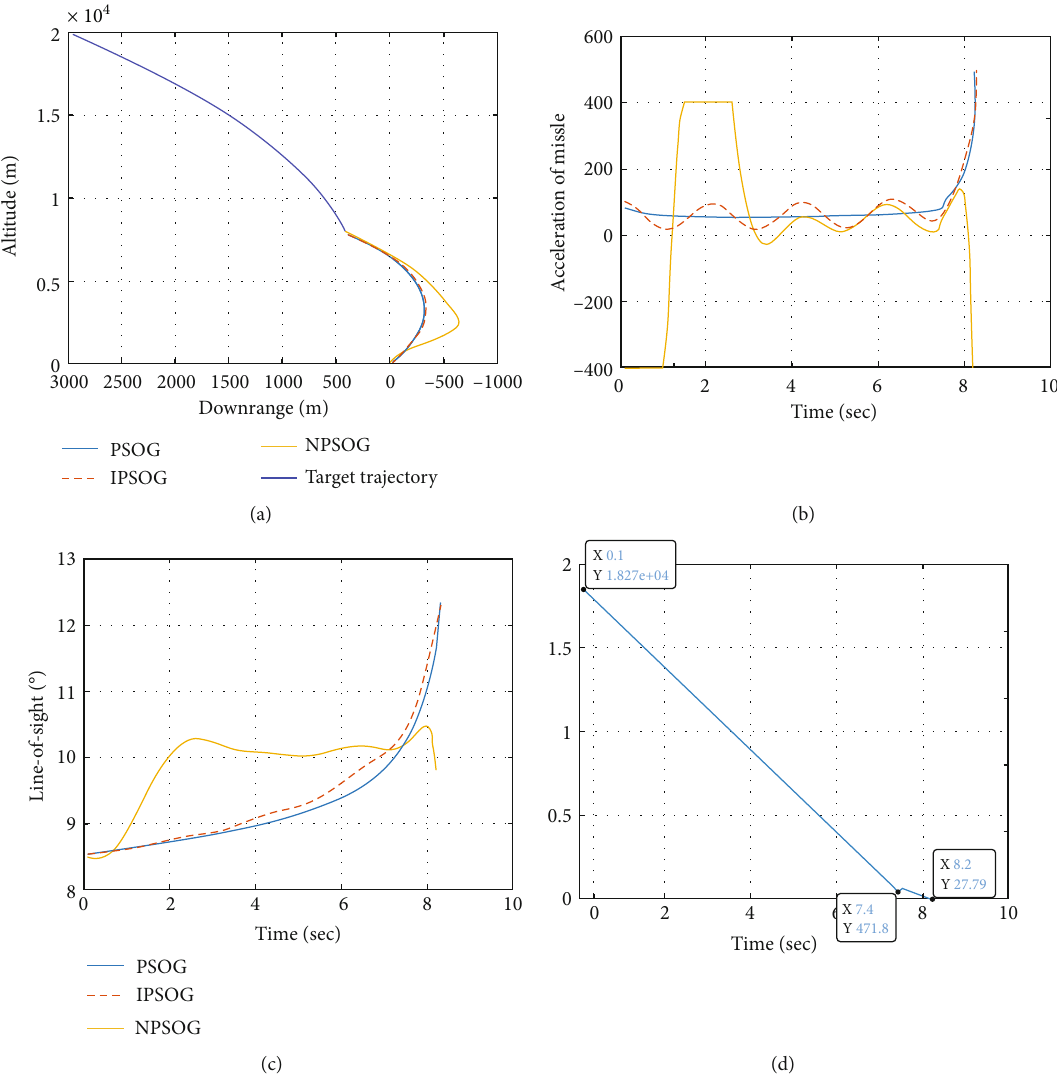
Figure 5: Simulation results of intercepting step-maneuvering hypersonic